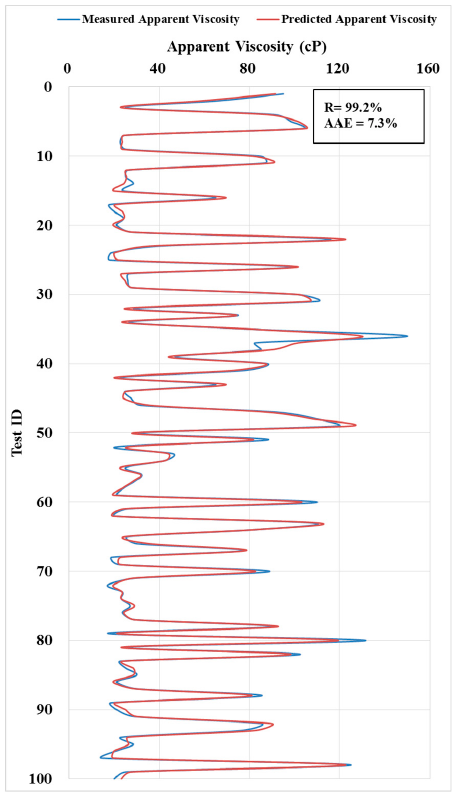
Figure 8. Apparent viscosity prediction using an artificial neural network for training data (100 samples).